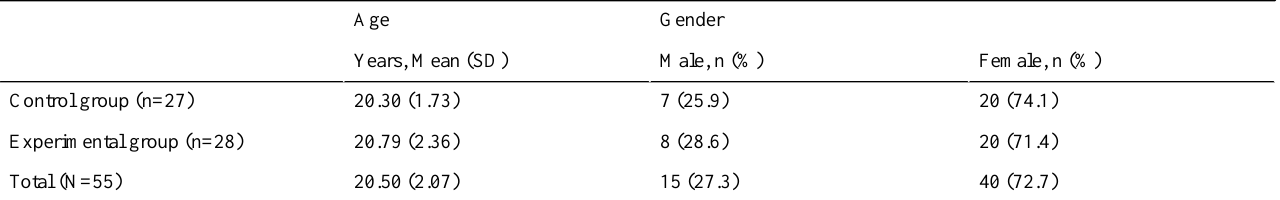
Table 1. Descriptive statistics of demographics. GenderAge